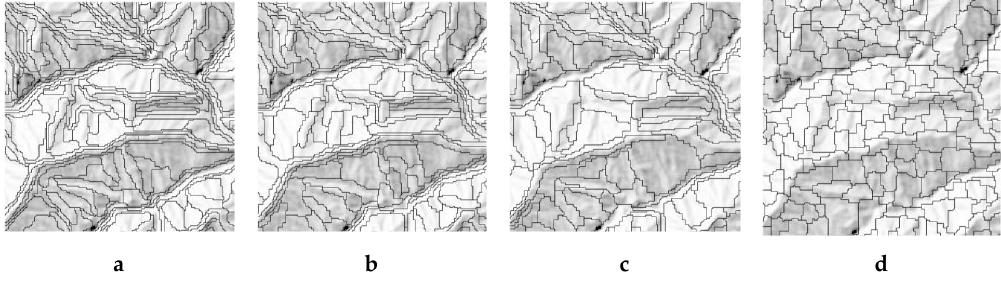
Figure 6. Segmentation at scale 8 with changes in shape and compactness parameters ( a ) shape: 0.1;